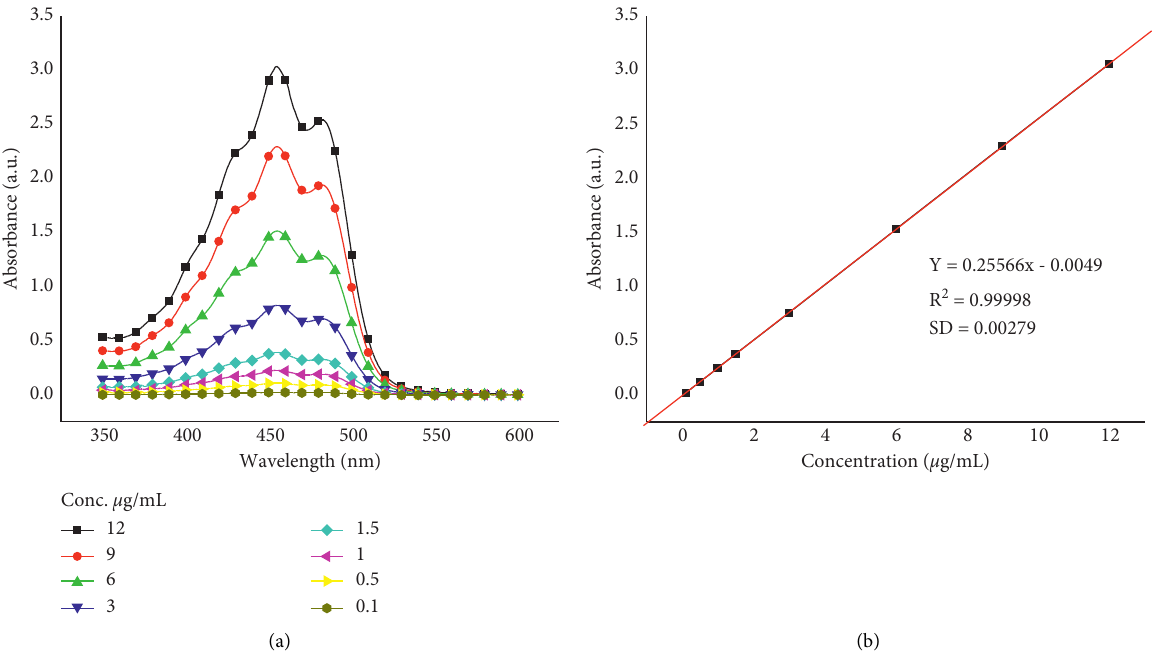
Figure 5: UV-VIS spectra of different concentrations of standard β -carotene in acetone (a) and calibration curve (b). Table 1: Content ( µ g/g) of β -carotene from the three parts of pumpkin, namely, peel, flesh, and seed samples using the UV-VIS method. Sample